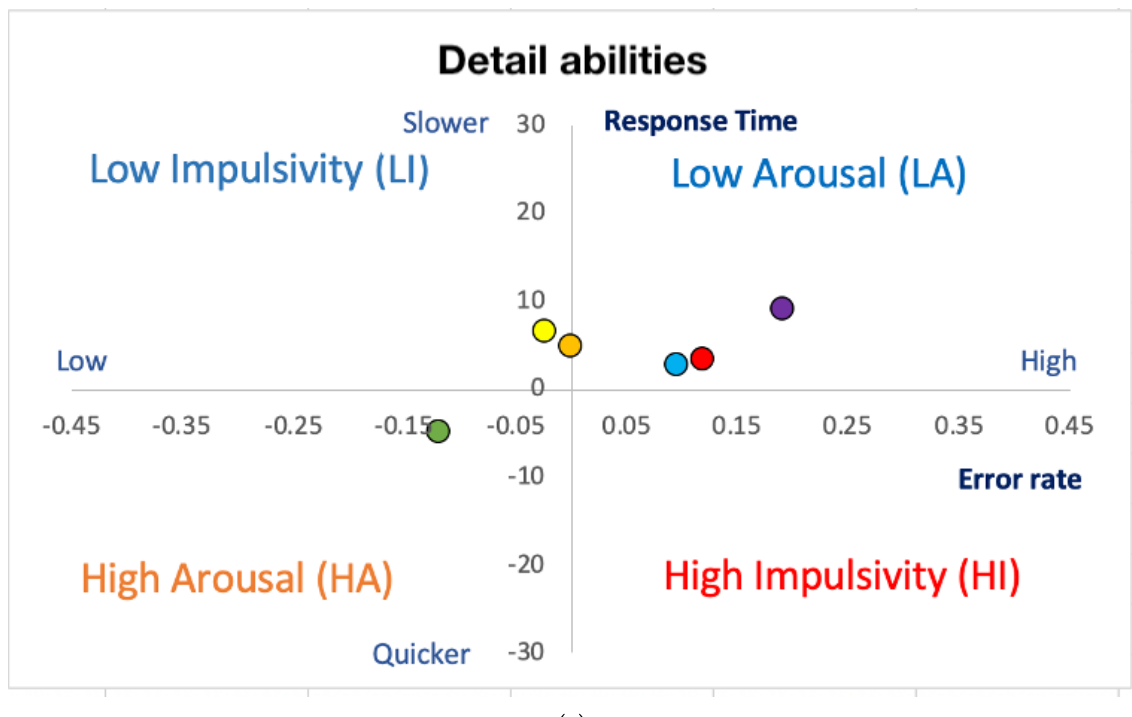
Figure 6. ( a ) Response time of participants’ performance in detail abilities by background colours; ( b ) Error rate of participants’ performance in detail abilities by background colours; ( c ) Colour impacts on detail imagination abilities visualised in the Error-Speed space. The bars represent mean changes, while the error bars are the standard error of the mean across individual participants.